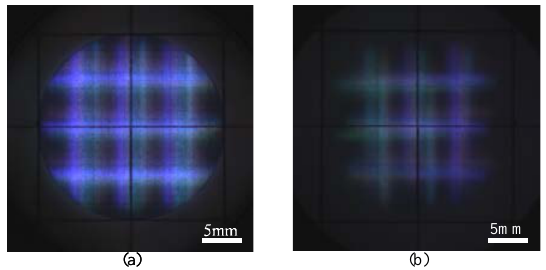
Figure 4. Adjustments of positions of eight LFDs using grid patterns displayed by all LFDs on ( a ) CDP and ( b ) plane above CDP with a length of 14 mm.